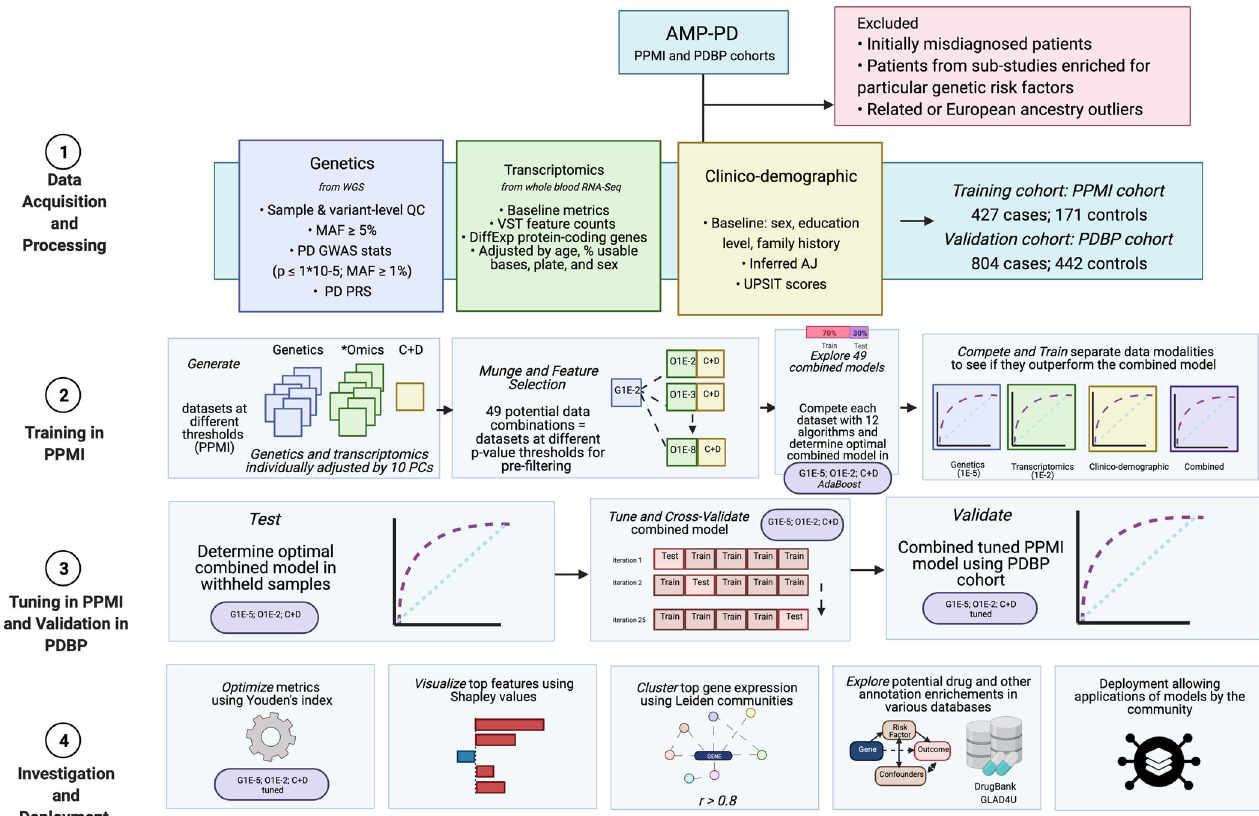
Fig. 1 Work fl ow and Data Summary. Scienti fi c notation in the work fl ow diagram denotes minimum p values from reference GWAS or differential expression studies as a pre-screen for feature inclusion. Blue indicates subsets of genetics data (also denoted as “ G ” ), green indicates subsets of transcriptomics data (also denoted as *omics or “ O ” ), yellow indicates clinico-demographic data (also denoted as C + D), and purple indicates combined data modalities. PD Parkinson ’ s disease, AMP-PD accelerating medicines partnership in Parkinson ’ s disease, PPMI Parkinson ’ s progression marker initiative, PDBP Parkinson ’ s disease biomarker program, WGS whole-genome sequencing, GWAS genome-wide association study, QC quality control, MAF minor allele frequency, PRS polygenic risk